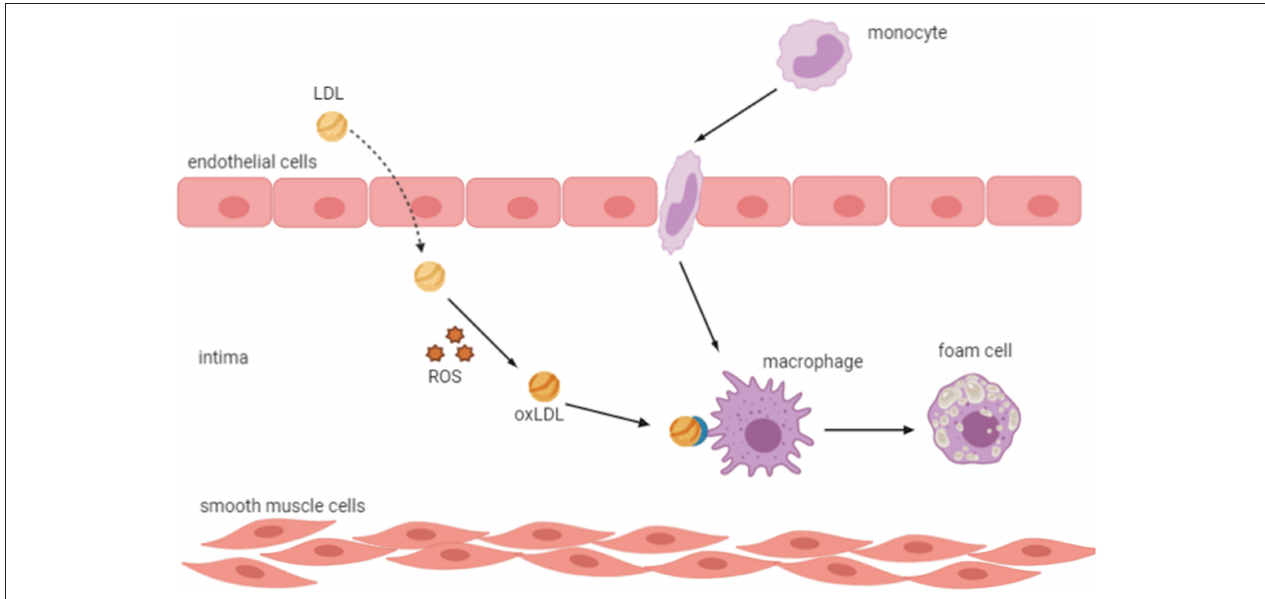
FIGURE 4 | Oxidized LDL transforms macrophages into foam cells. An increase in oxidative stress results in vascular permeability alterations, which allow the entrance of LDL into the vascular intima, where it is oxidized and induces endothelial cells to express leukocyte adhesion molecules and subsequent binding of circulating inflammatory cells and their migration into the subendothelial space. Oxidized LDL is taken up by scavenger receptors of macrophages, which transform into foam cells resulting in the formation of the fatty streak, the initial lesion of atherosclerosis. LDL, low-density lipoprotein; ROS, reactive oxygen species; ox-LDL, oxidized LDL.